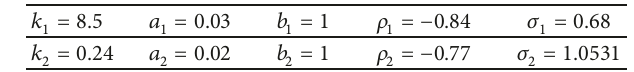
Table 3: Parameters of